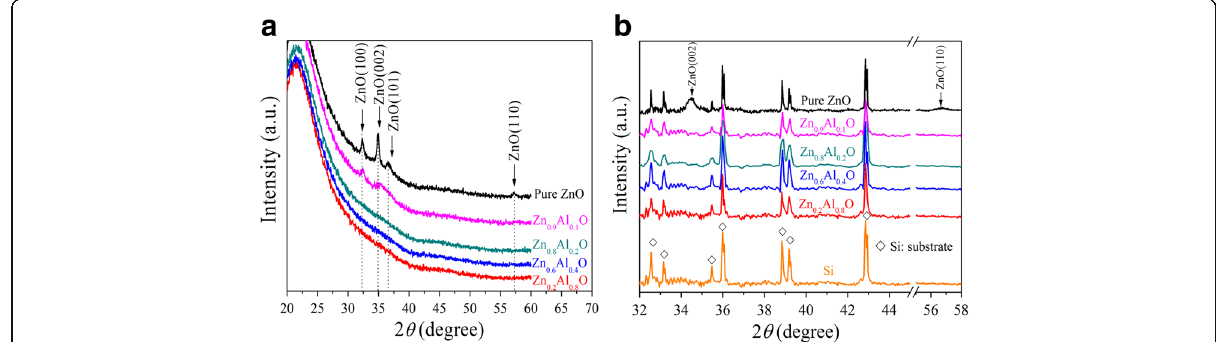
Fig. 1 XRD patterns of Zn x Al 1- x O samples deposited on a quartz substrate and b Si